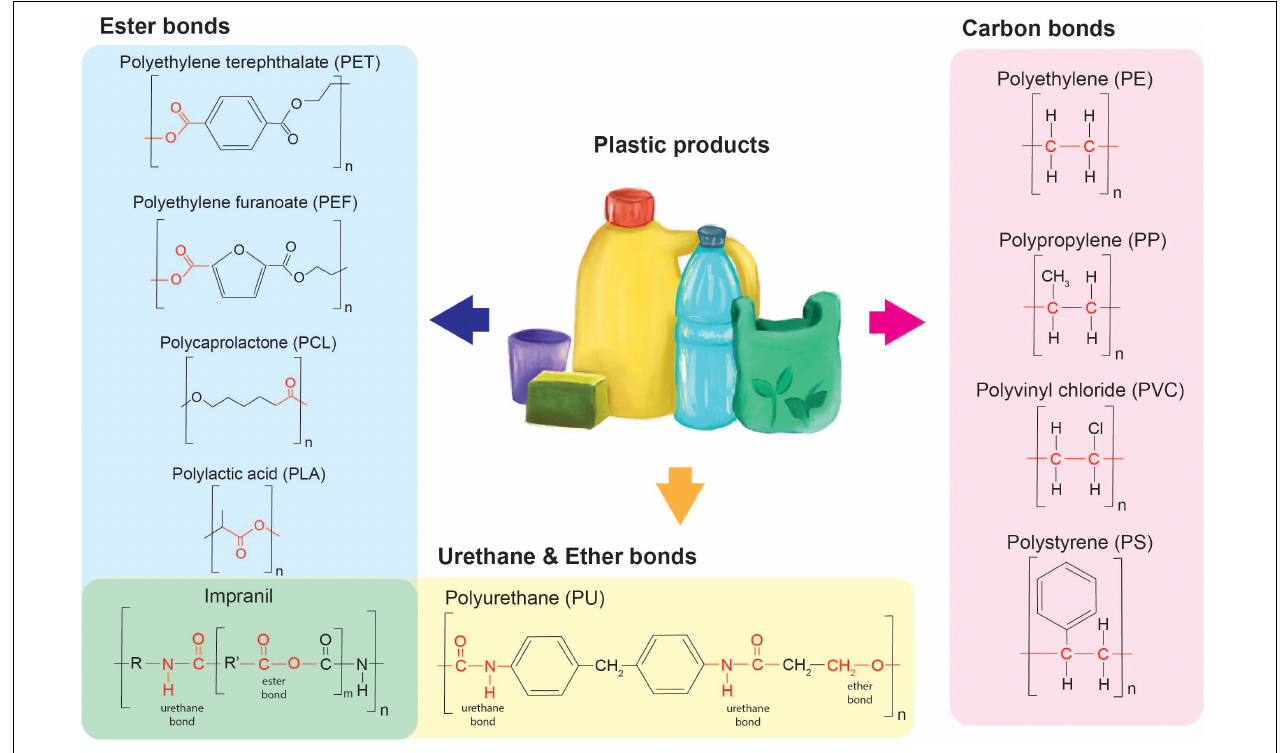
FIGURE 1 | Plastics and their specific chemical